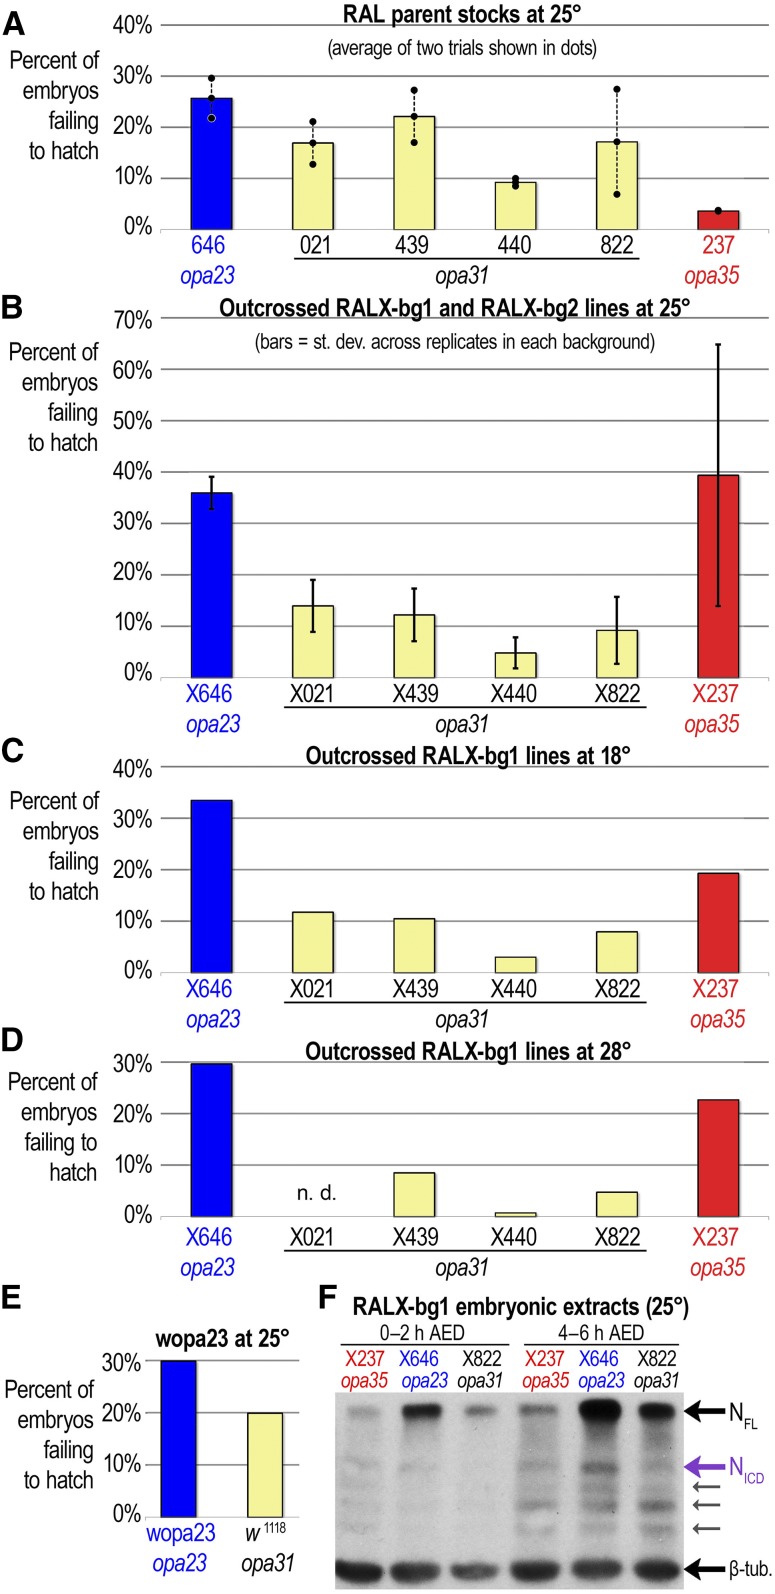
Lines with rare opa variants have aberrant Notch expression and suffer embryonic failure. (A) Among six isogenic RAL lines assayed for the rate of embryonic failure (failure to hatch as larva by all causes), RAL-646, which carries the short opa23 allele, has the highest rate of failure, whereas RAL-237, which carries the long opa35a1 allele, has the lowest rate of failure. Four different RAL lines carrying wild-type opa31 alleles have intermediate levels of embryonic failure. Bars represent averages of two replicate trials shown as dots. (B–D) Embryonic failure is increased in outcrossed RALX lines carrying the extreme opa variants, whereas it is decreased in all of the opa31 outcrossed lines at 25° (B), 18° (C), and 28° (D). Bars in (B) represent averages of four replicate trials, two from each background, except RALX021-bg1, which was conducted only once. Error bars represent ±1 SD. RALX237-bg1 and RALX237-bg2 have a consistently higher level of embryonic failure than all the outcrossed opa31 lines, but the RALX237-bg2 failure rate is much higher than RALX237-bg1. (E) The recombined wopa23 line carrying a smaller region of the RAL-646 X chromosome and outcrossed into the FM7 and w1118 background shows a higher level of embryonic failure than the w1118 stock. (F) Western blot of embryonic extracts from RALX-bg1 strains carrying different Notch opa variants from before (0–2 hr after egg deposition, or AED) and after Notch activation (4–6 hr AED), when the cleaved Notch intracellular domain (NICD, purple arrow) is more prominent. Gels were probed with anti-NICD antibody and anti-β-tubulin antibodies. Smaller NICD degradation products can be seen below NICD (smaller gray arrows).